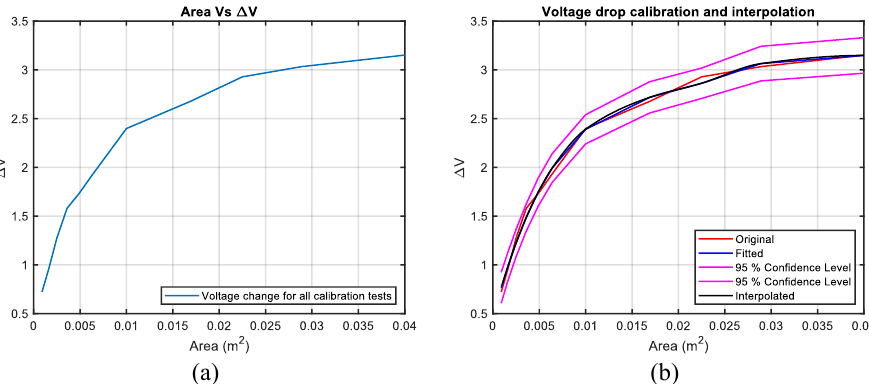
Figure 10. Calibrated voltage drop curve for single sensor: ( a ) sensor voltage drop; ( b ) calibrated and interpolated voltage drop.